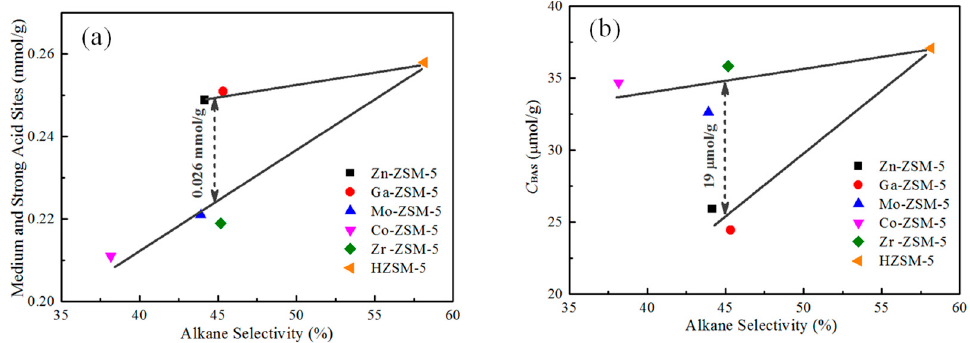
Figure 8. The impact of medium and strong acid sites ( a ), and Brønsted acid sites ( b ) on alkane selectivity.